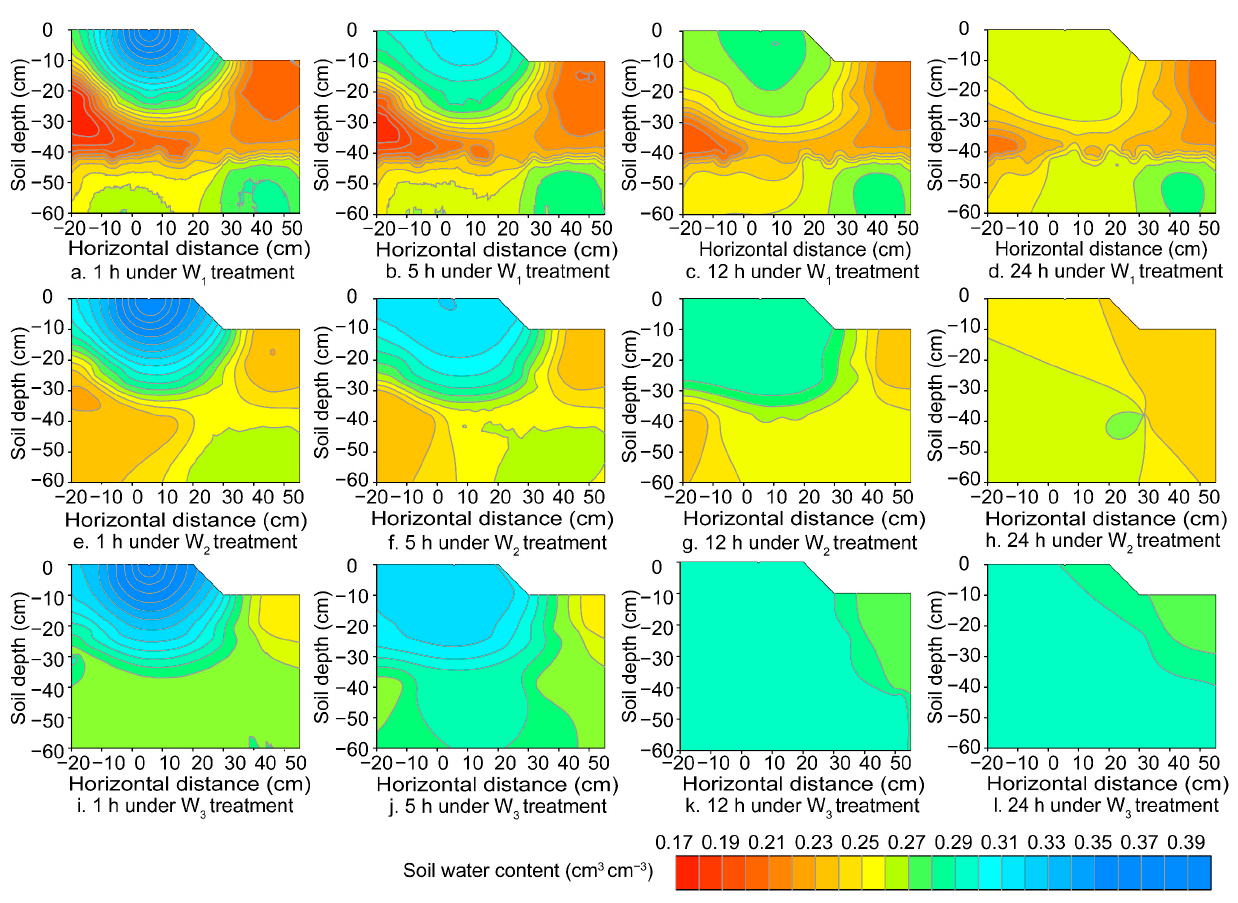
Figure 5. Soil water movement (cm) at 1 h, 5 h, 12 h, and 24 h after irrigation began under different water treatments, in blooming and setting stage.